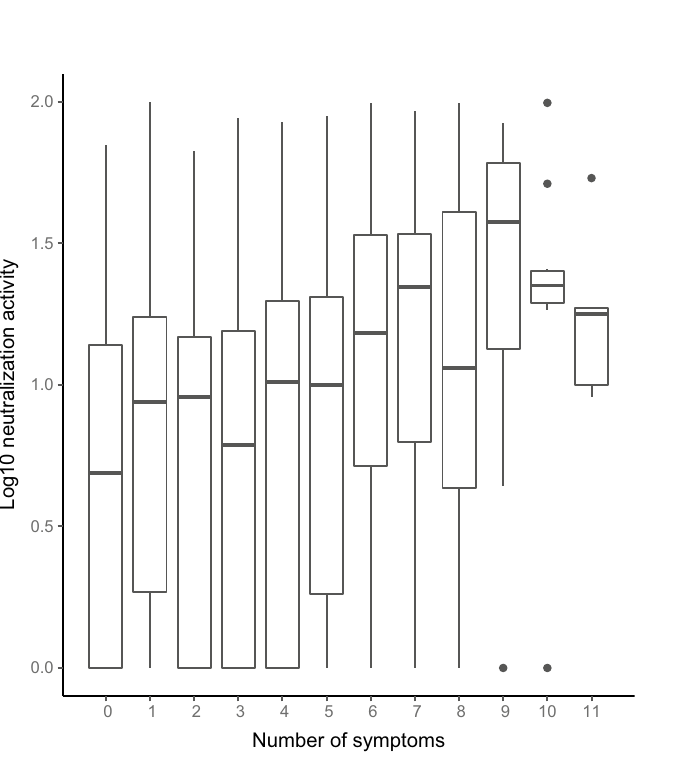
Table 3. Coefficients, with standard errors in parentheses, from linear regression models with log 10 surrogate neutralization levels as outcome variable. N = 790. * p < 0.05; **p < 0.01; ***p < 0.001.